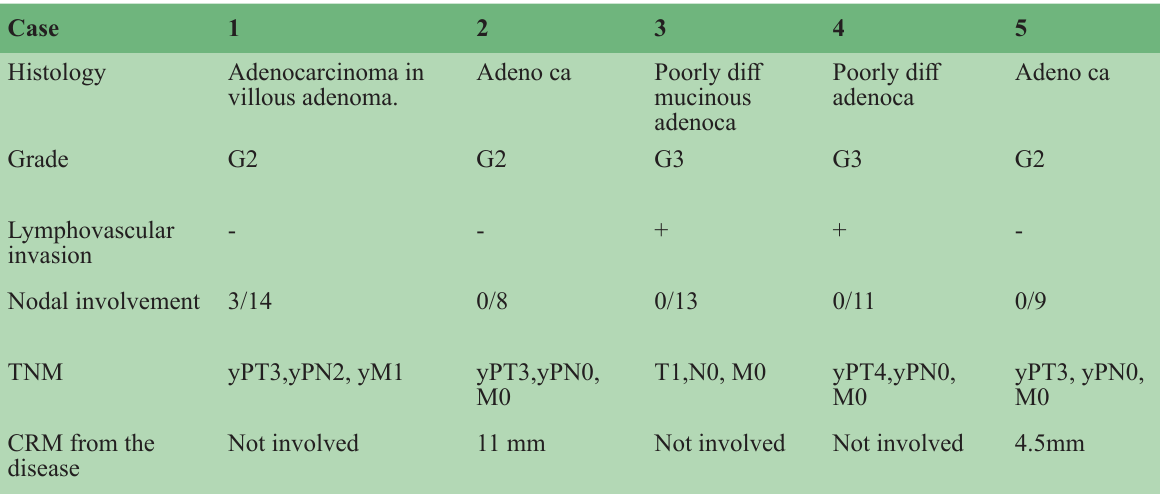
Table 3: Pathology